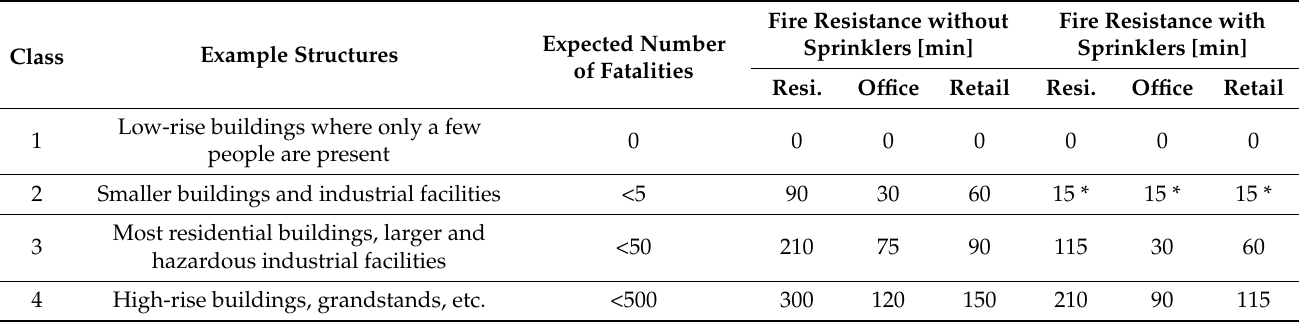
Table 12. Fire resistance recommendations based on the principle of relative (marginal) lifesaving costs, using ISO 2394:2015 consequence